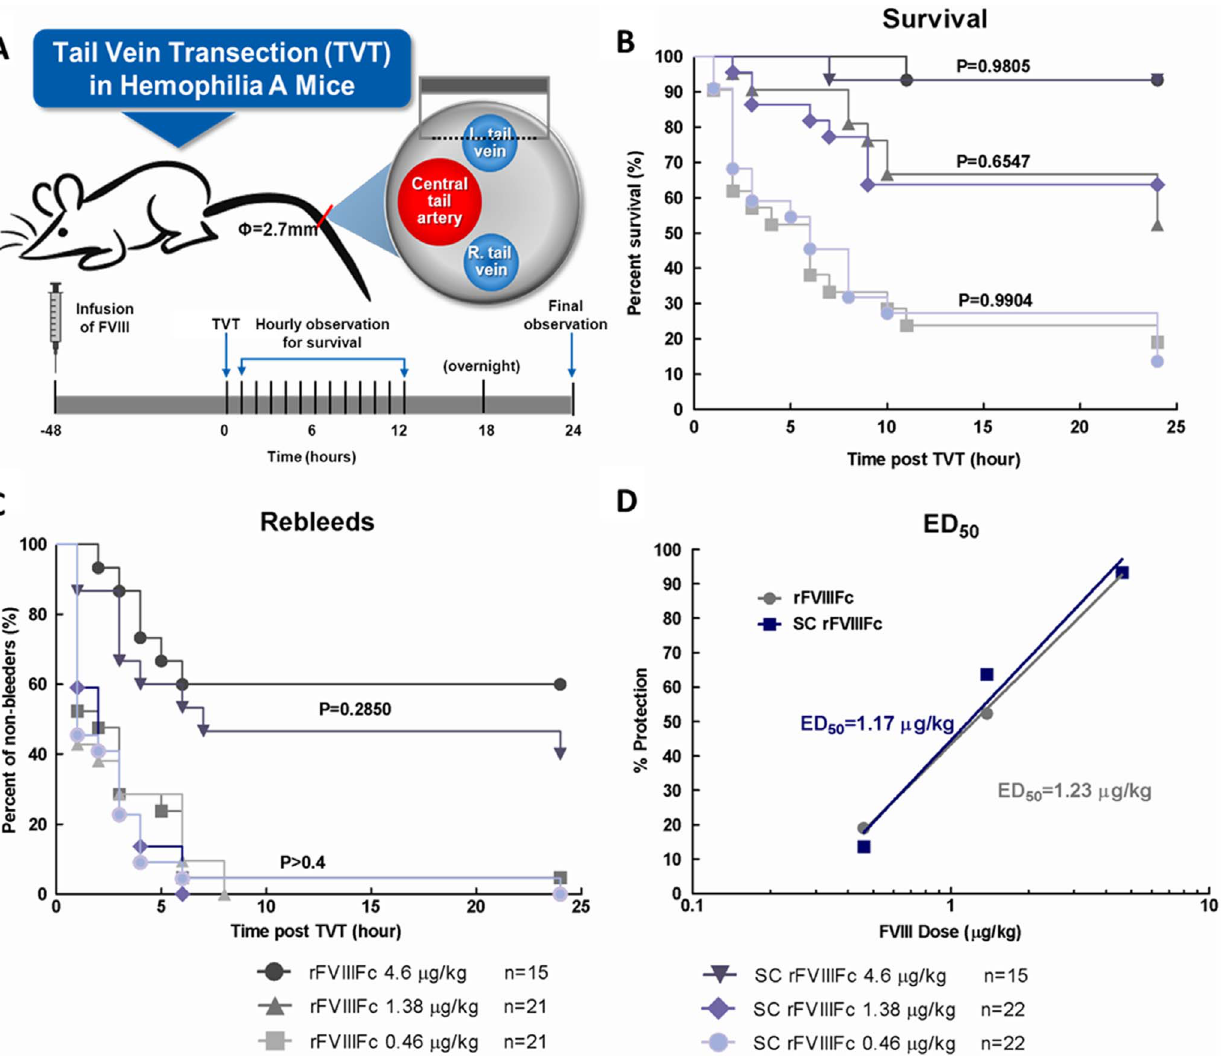
Figure 6. SC rFVIIIFc and the rFVIIIFc demonstrated equivalent in vivo efficacy in a HemA mouse bleeding model. Tail-bleeding of HemA mice was induced via transection of one of the lateral veins at 48 hr post i.v. dosing of SC rFVIIIFc or rFVIIIFc (0.46, 1.38 and 4.6 m g/kg). Mice were monitored for survival and re-bleeding for 24 hr post injury. (A) Schematic experimental design of TVT model. (B) 24 hr post TVT survival curves (C) 24 hr post TVT re- bleeding curves from experimental animals. (D) The linear regression curve of the percentage of protection (survival rate) versus the log (base 10) of the dose was plotted. The ED 50 was extrapolated from the